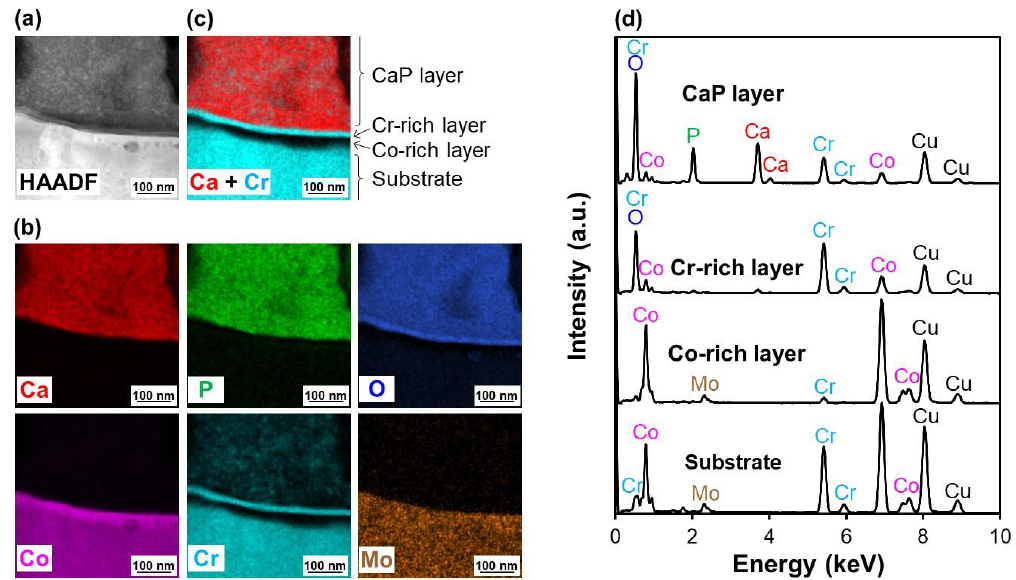
Figure 9. ( a ) HAADF image, ( b ) STEM-EDX elemental (Ca, P, O, Co, Cr and Mo) maps and ( c ) STEM-EDX merged elemental (Ca + Cr) map of the ultra-thin cross-section of the LAB-processed (30 min) Co−Cr alloy substrate (interface with the CaP layer). ( d ) STEM-EDX spectra obtained from each region in ( c ). The Cu peaks in ( d ) are derived from the grid that was used to mount the cross-sectional ultra-thin sample. The C peak in ( d ) is derived from the oil-based ink (soft protective cover) that was applied to the substrate surface prior to the FIB processing.